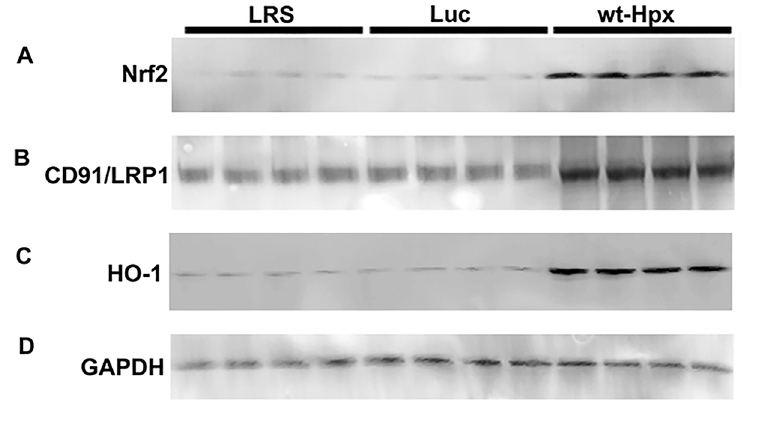
Figure 5. Hemopexin gene therapy increases Nrf2, LRP1/CD91 and heme oxygenase-1 (HO-1) expression in the livers of NY1DD sickle mice. NY1DD mice were hydrodynamically infused with lactated Ringer’s solution (LRS), SB 100X + Luc or SB 100X + wt-Hpx (n = 4). Liv- ers were harvested 4 wks later after measurement of heme-induced stasis and used for western blots. (A) Liver nuclear extracts were immunostained for (A) Nrf2 (MW 98 kDa),